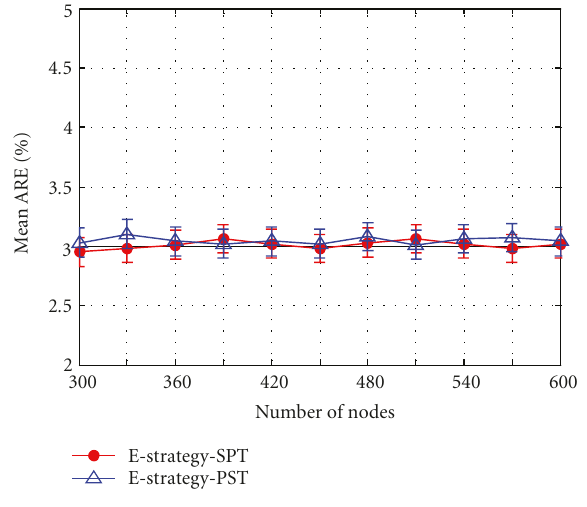
Figure 7: Accuracy versus number of sink